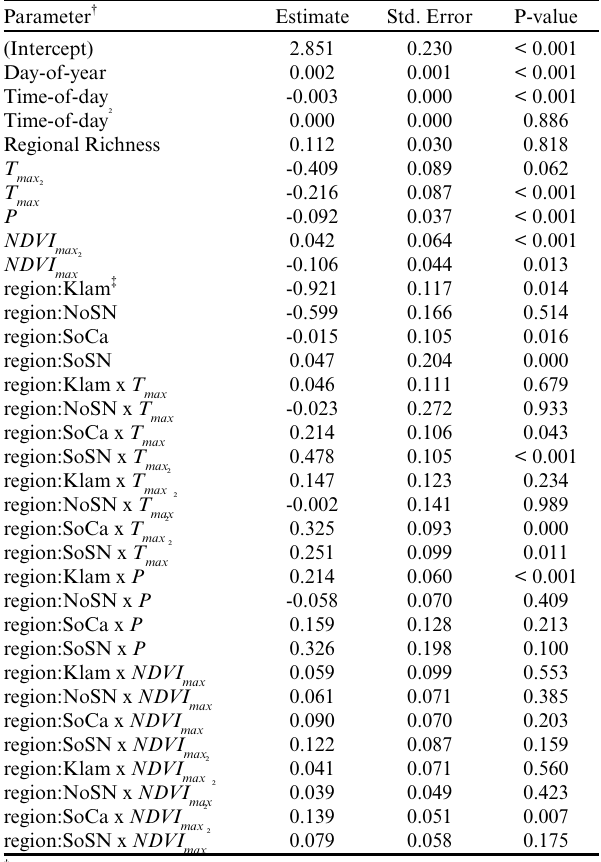
Table 5 . Parameter estimates, standard errors, and statistical significance for the top model explaining observed bird richness as a function of environmental factors and regional